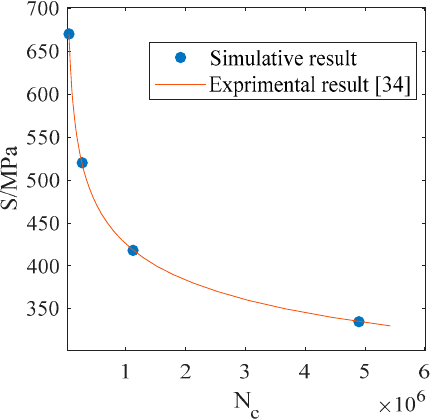
Figure 5. S-N curve of steel wire without the initial defect under uniaxial tensile fatigue loads.